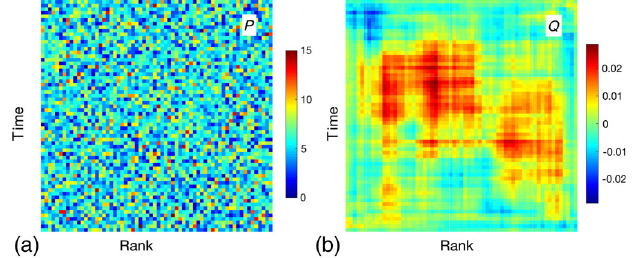
FIG. 5. Contrast between Q and P representations. (a) The fine speckle from a single realization of P from the stationary iid Monte Carlo simulation, as described in the text. (b) The corresponding spatial coherence in Q (for any noise pdf). The average population per pixel on the left is ð 365 = 64 Þ ≈ 5 . 7 . Whereas P is finely speckled, Q exhibits a spatial structure, which, in this realization, is associated with a warming trend. Structures become more pronounced at the ensemble level (see Fig. 6). there is no need to limit our development to a Gaussian distribution; all white noise distributions are equivalent.